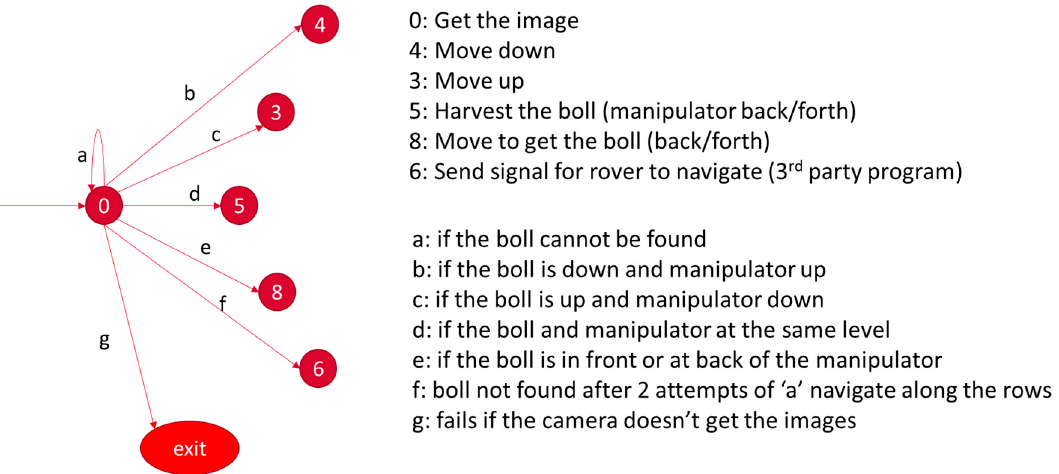
Figure 14. Linear transformation of the finite state machine diagram (Figure 13) of the rover states and transitions.